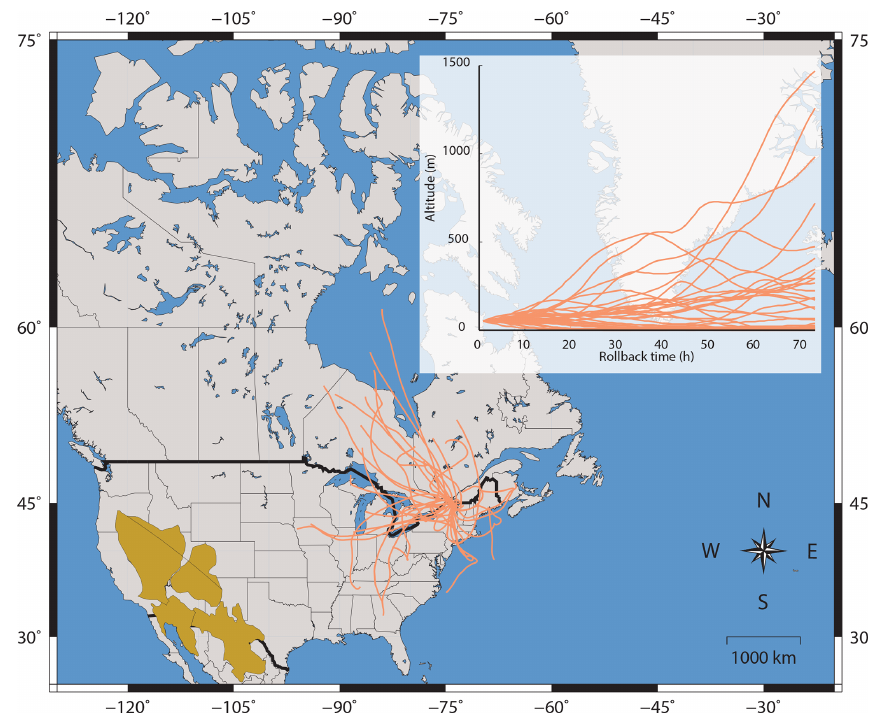
Figure 4. Three-day back-trajectories modelled using the HYSPLIT software for the sampling stations in Montreal. Back trajectories are calculated using an initial height of 50ma.s.l. (above the sea level). American deserts are also shown in brown and include the Great Basin, the Mohave desert, the Chihuahua desert and the Sonoran